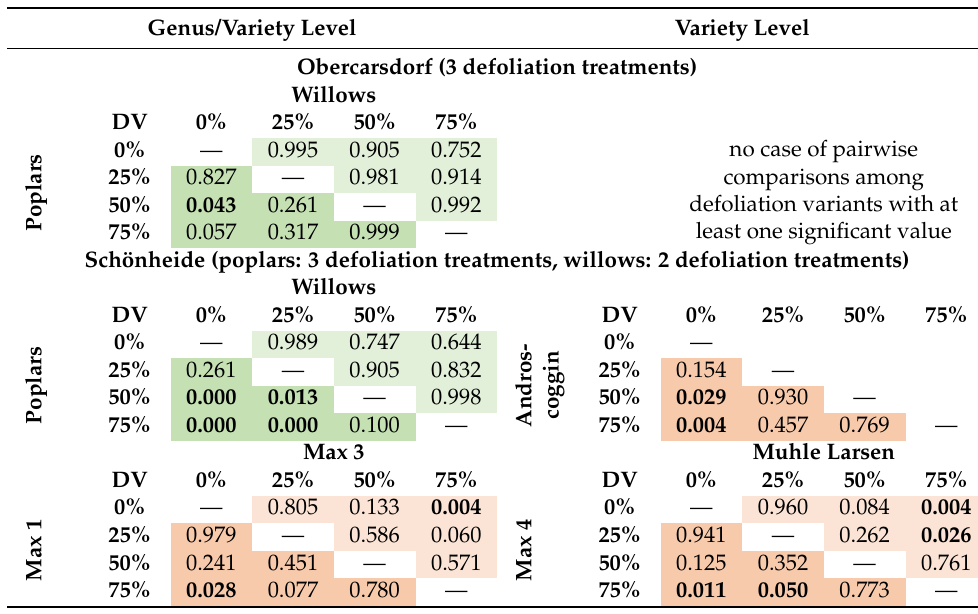
Table 3. p values of pairwise comparisons of plant heights among defoliation variants (DVs) for both tree genera (green) as well as for all varieties with at least one significant value (orange) on the study sites in Obercarsdorf and Schönheide with regard to the number of defoliation treat- ments prior to the start of the growing season in 2009 via Tukey HSD test (bold values indicate statistically significant differences).